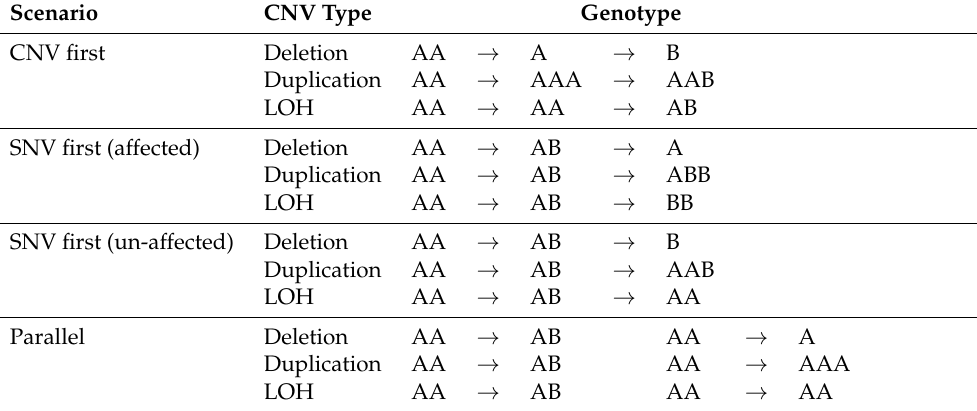
Table A1. Influence of overlapping CNVs on SNVs, dependent on the underlying scenario of overlap. For CNV first, a genomic location is first affected by a copy number variant. Subsequently, the location is affected by a point mutation (allele A changed to B). For SNV first, a genomic location is first affected by a point mutation. For ‘affected’, the mutated allele is affected by the subsequently acquired copy number variant, e.g., the mutated allele being deleted. For ‘un-affected’, the mutated allele is not affected by the subsequently acquired copy number variant, e.g., the healthy allele being deleted. For parallel, SNV and CNV are assumed to affect different